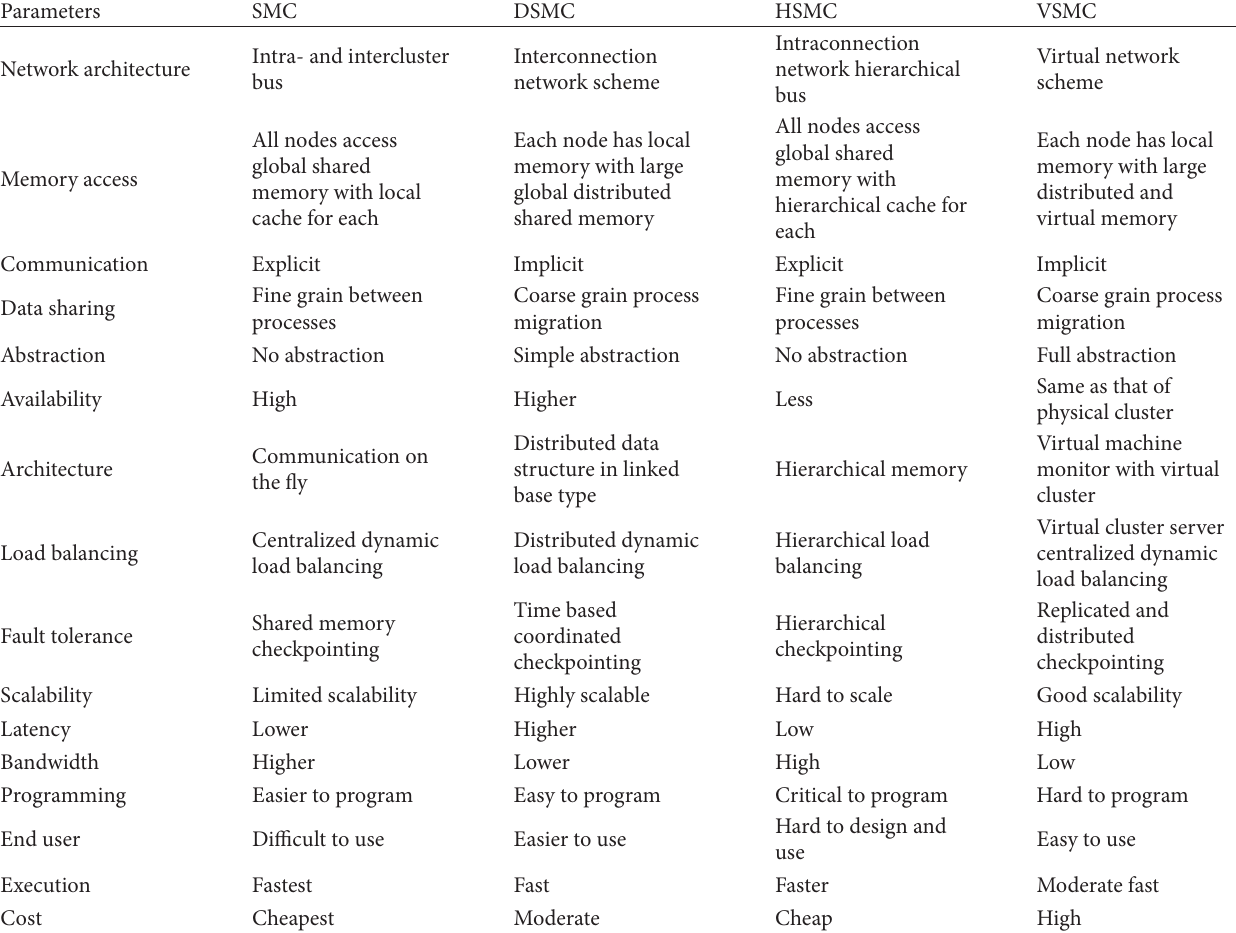
Table 1: Summary of performance comparison of cluster computing interconnection